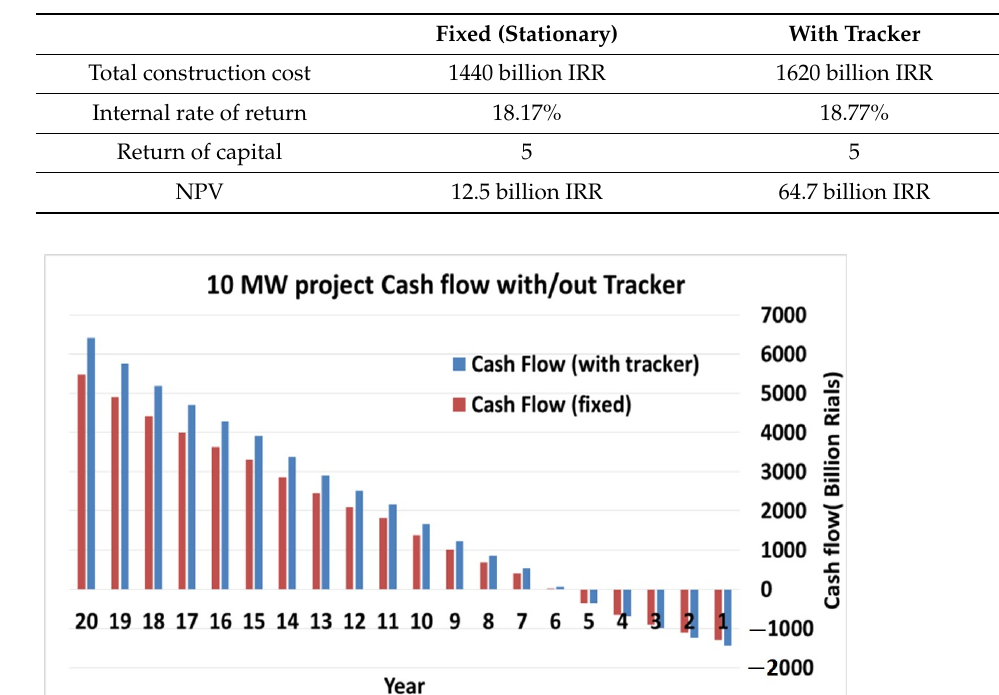
Figure 18. Comparison of repair and maintenance costs of a fixed-base and tracking power plants (bottom figure) and the forecast of the income of a 10 MW tracking power plant in Qom (top figure). Table 9. Economic comparison of 10 MW power plants with/out trackers.